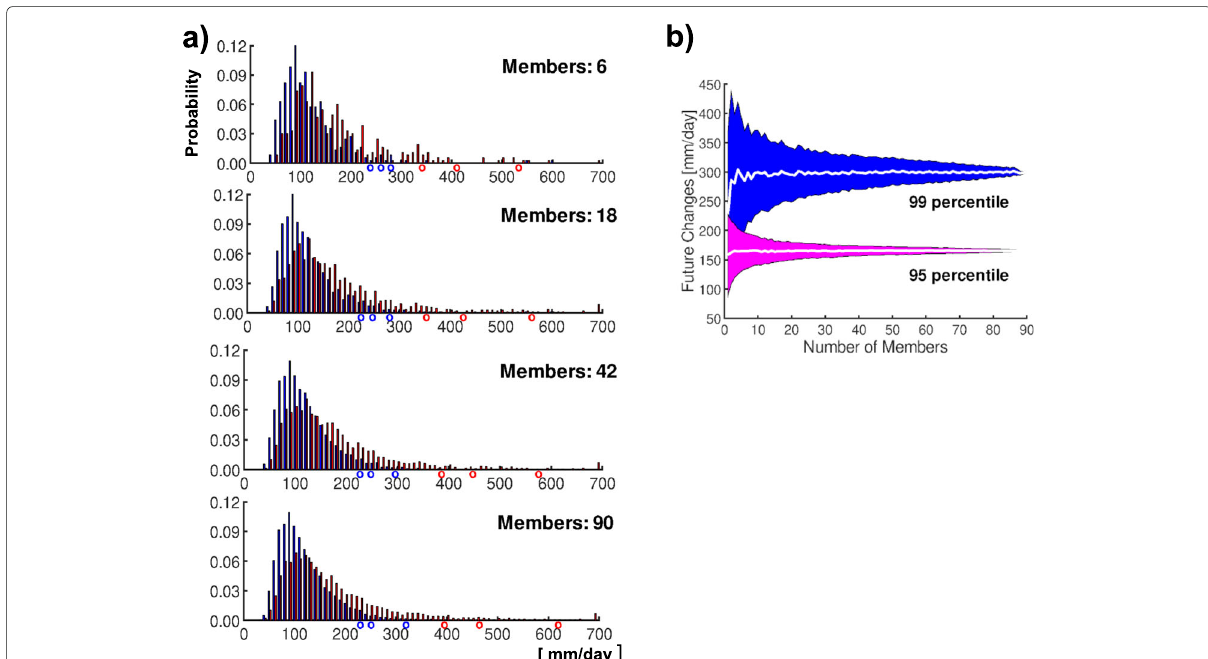
Fig. 4 a Histograms of annual maximum 1-day precipitation (mm/day) of each year in the past (blue) and +4 K (red) regional climate simulations (d4PDF-R) at Tokyo, for cases of a certain set of 6, 18, 42, and 90 members as aligned from the top to the bottom. Members plotted are chosen evenly from 15 simulations with six different SST trends. Colored circles along the abscissas in each histogram indicate positions at the 95, 97, and 99 percentiles for past (blue) and +4 K (red) climates. b The mean future changes (line) and the one-sigma uncertainties (shade) in the 95 (red) and 99 (blue) percentile maximum daily precipitations estimated nonparametrically from the